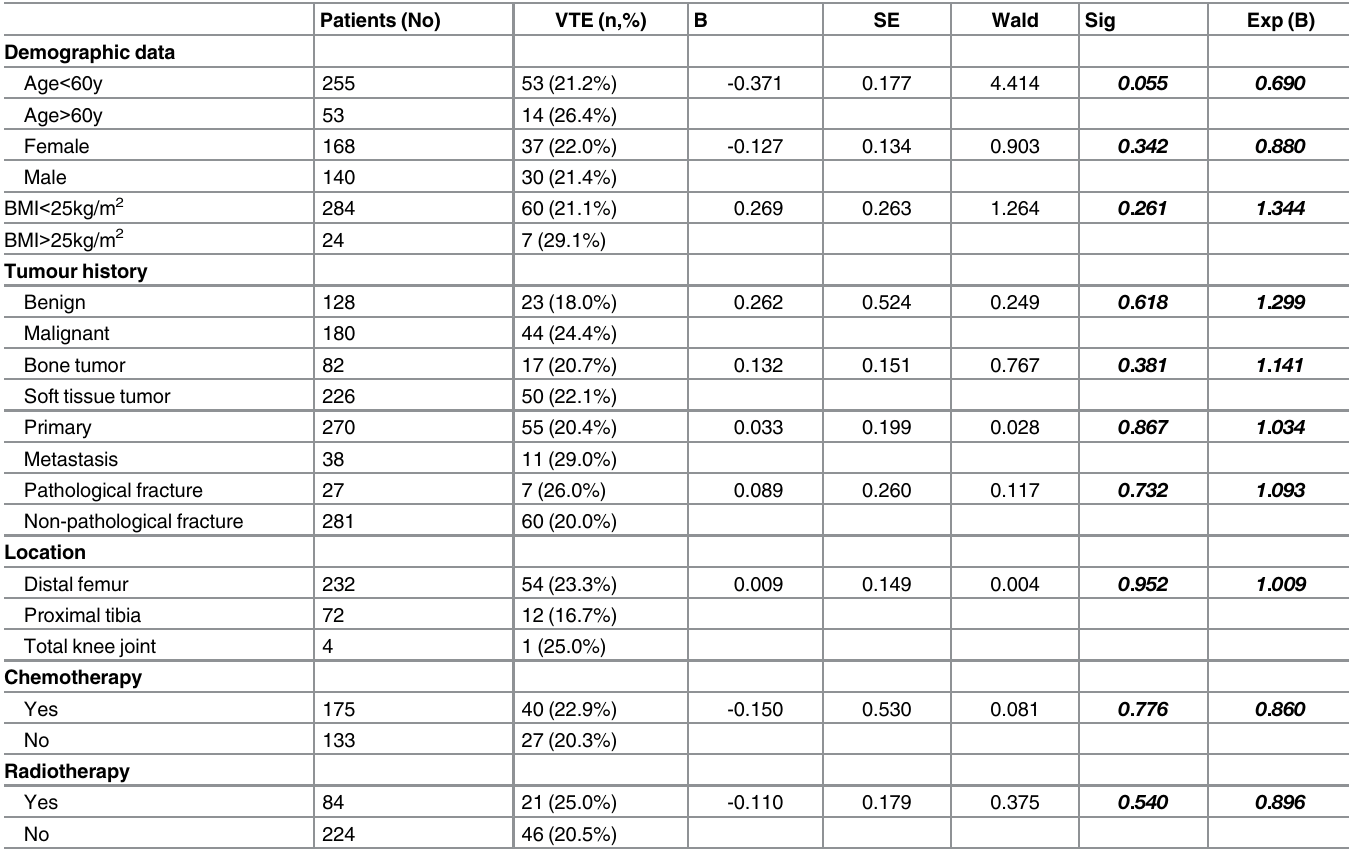
Table 2. Potential risk factors of VTE for patients with musculoskeletal tumors around the knee with multivariate cox regression analyses.